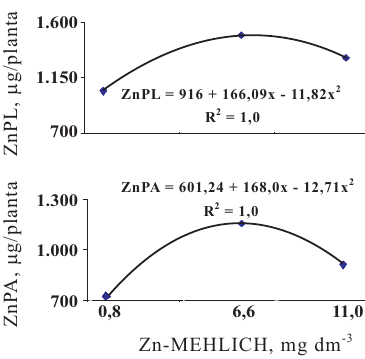
Figura 3. Conteúdo de zinco na planta inteira (Zn–PL) ou na parte aérea (Zn–PA) em função do teor disponível no solo pelo extrator DTPA, na espécie C. canephora (AP).